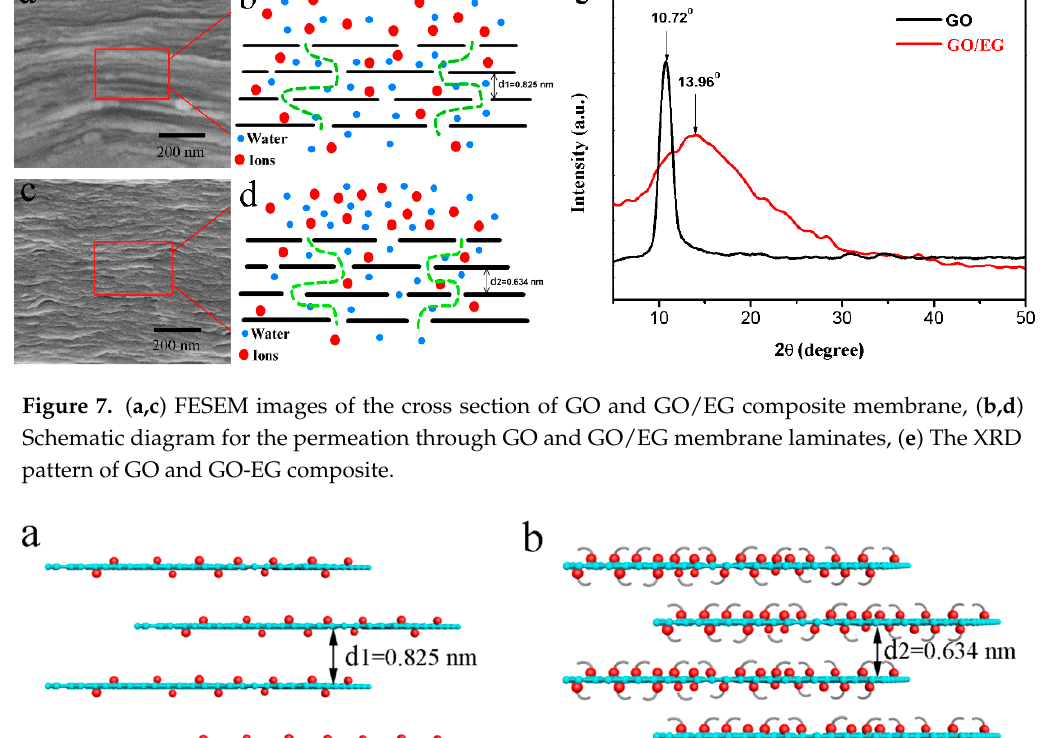
Figure 6. The rejection rate of RhB of GO and GO/EG membranes.